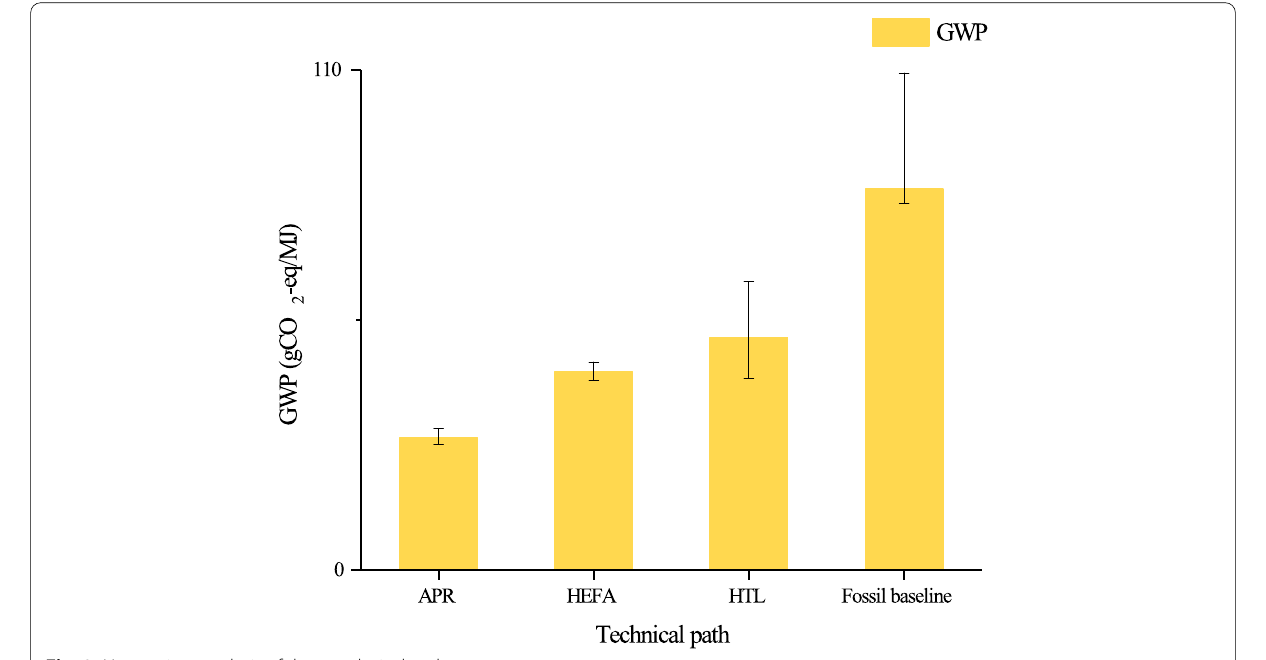
Fig. 8 Uncertainty analysis of three technical